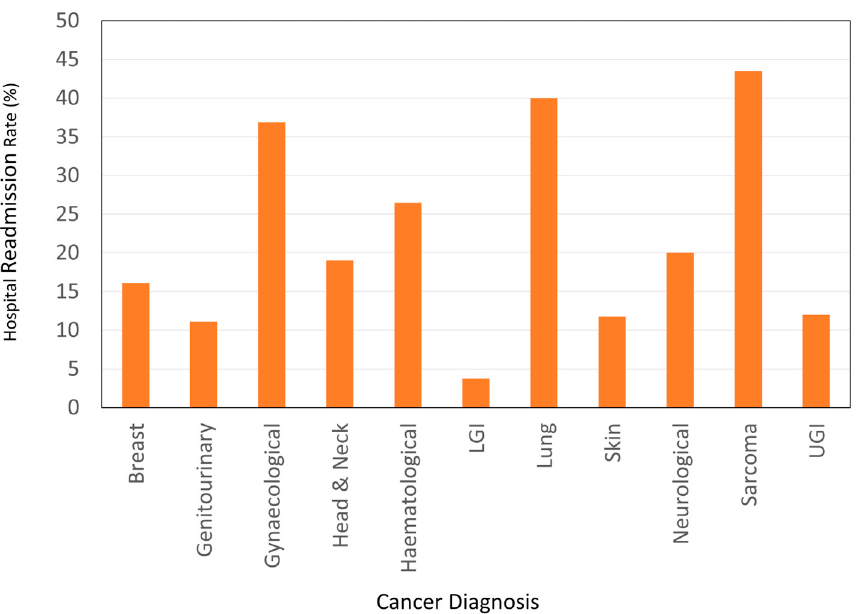
Figure 3. Variability of 30-day, all-cause hospital readmissions by cancer diagnosis. Note: LGI = lower gastrointestinal cancer and UGI = upper gastrointestinal cancer.